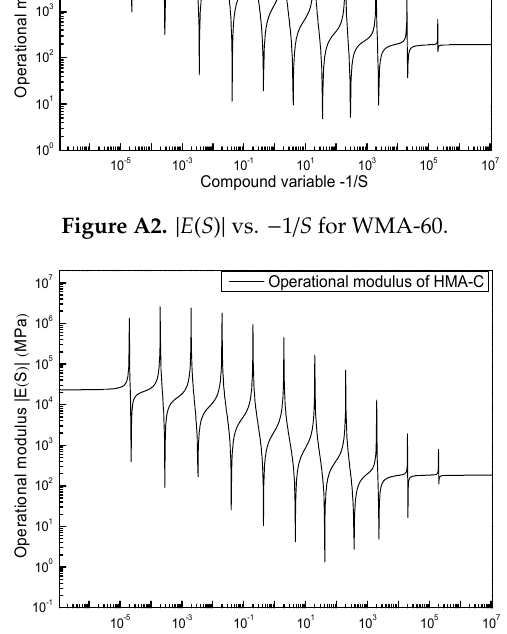
Figure A3. |𝐸(𝑆)| vs. −1/𝑆 for HMA-C.